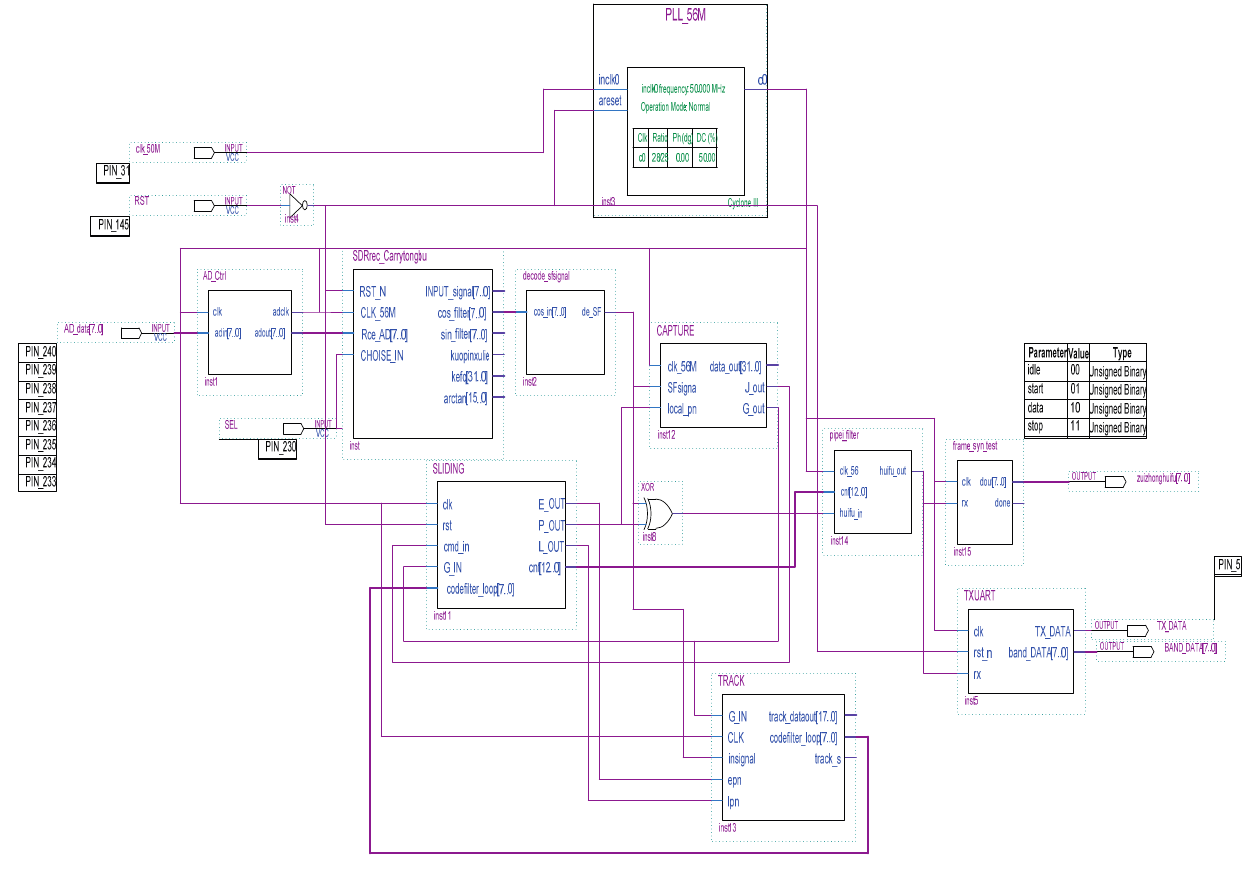
Figure 34. The top-level design of DSSS